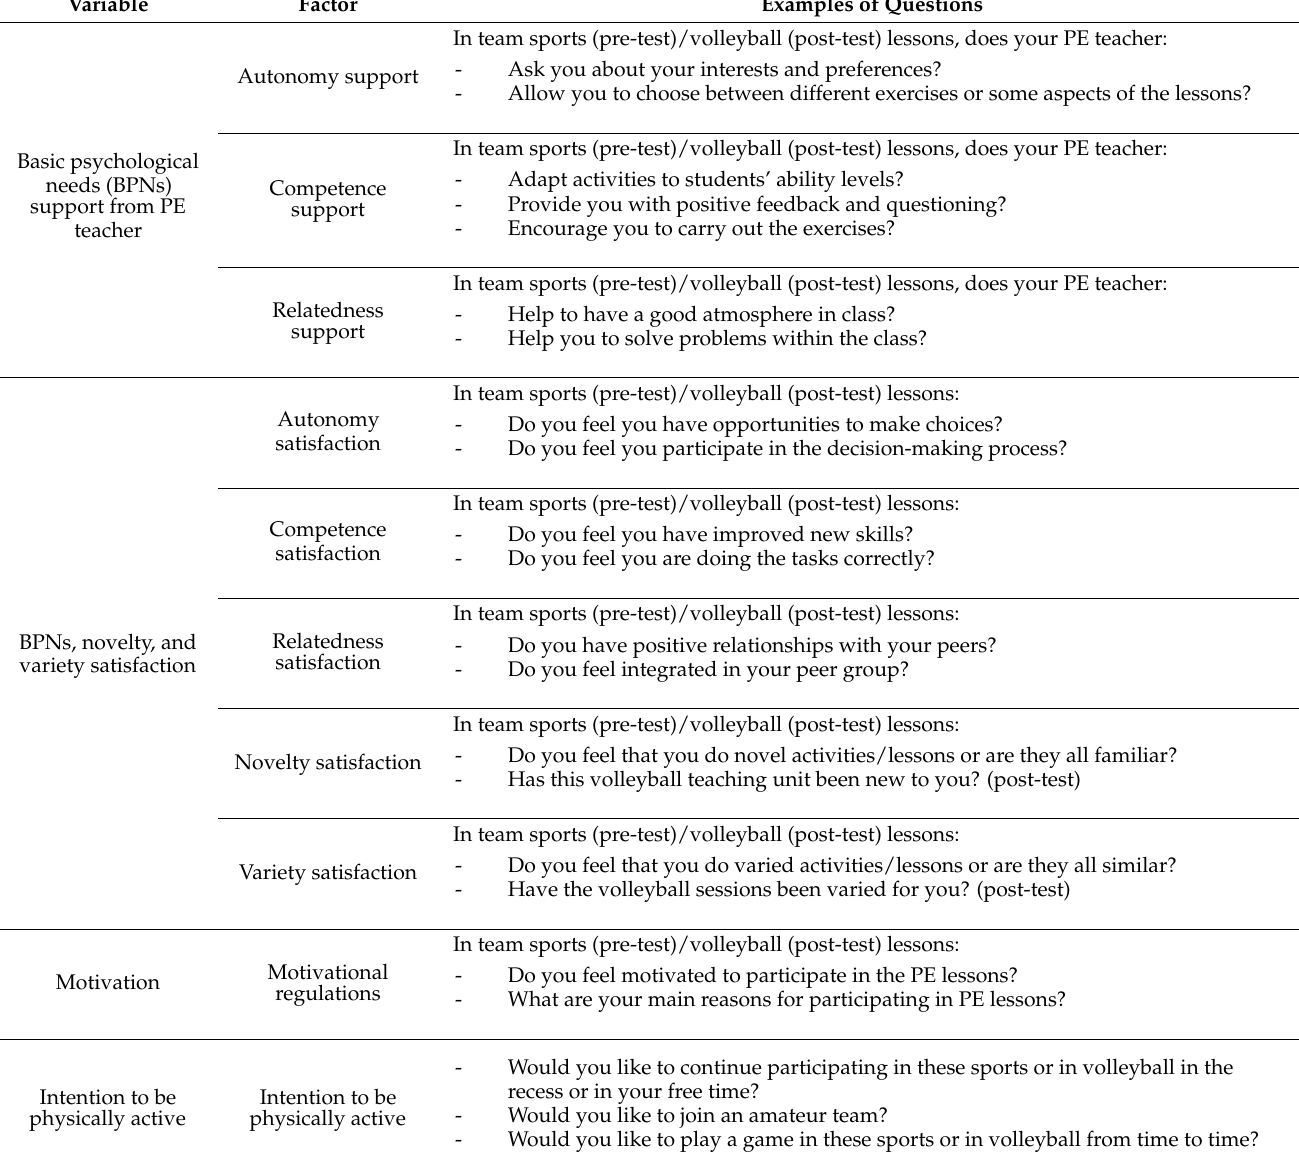
Table 1. Self-determination theory (SDT) questions asked to the focus